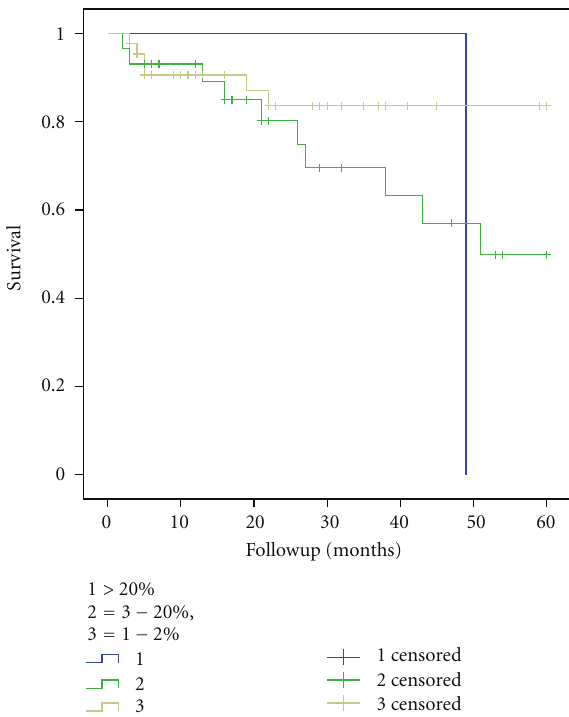
Figure 5: 5-year survival rates according to Ki-67 index for all